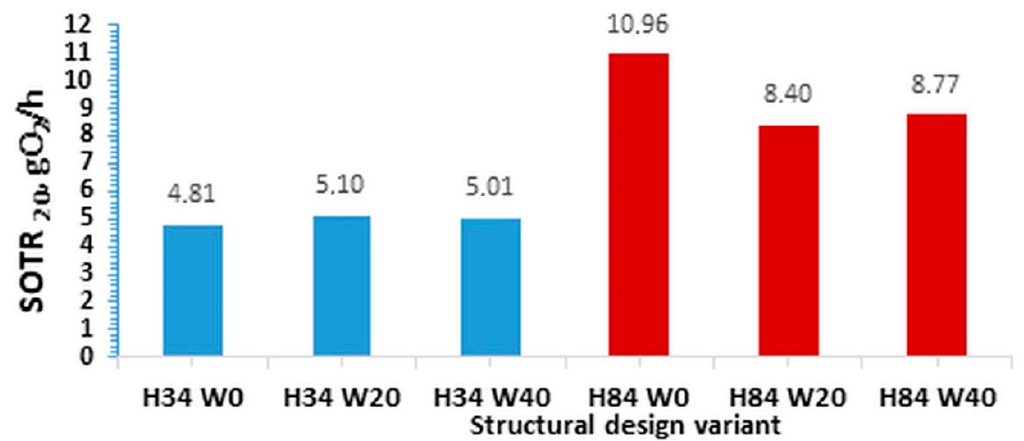
Figure 12. Standard oxygen transfer rate (SOTR 20 ) in the tested barbotage reactor.